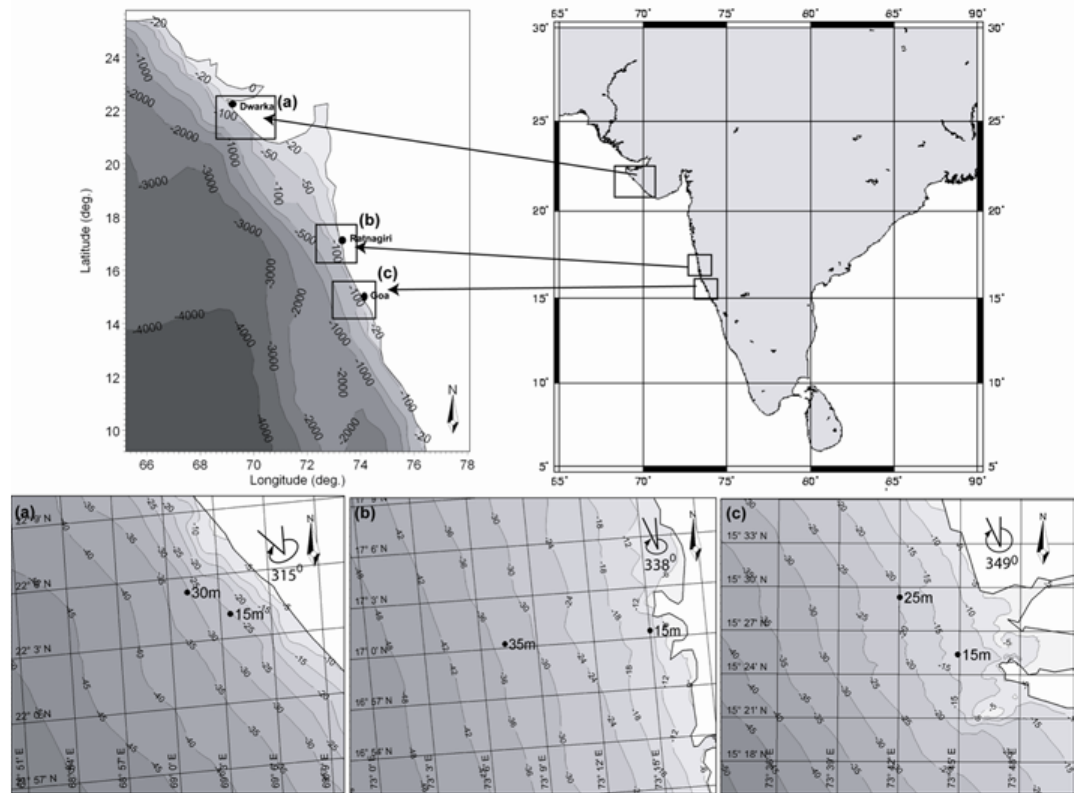
Fig. 1. Wave measurement location and its bathymetry contours along the west coast of India. Angles mentioned in the figures are the orientation of the coastline w.r.t the